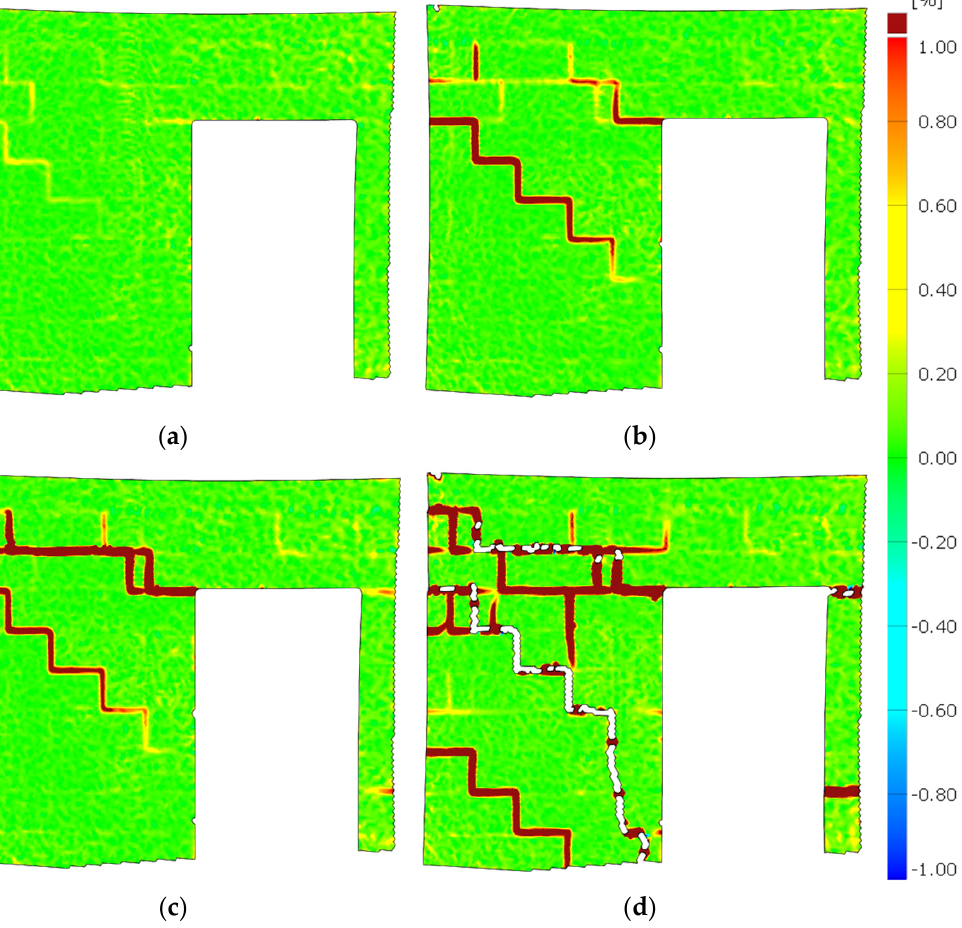
Figure 12. The crack propagation—MW-AAC-010/1 model; ( a ) crack pattern— H x = 32.23 kN; ( b ) crack pattern— H x = 46.39 kN; ( c ) crack pattern— H x = 58.22 kN; ( d ) crack pattern— H x = 42.40 kN (post-peak behavior).